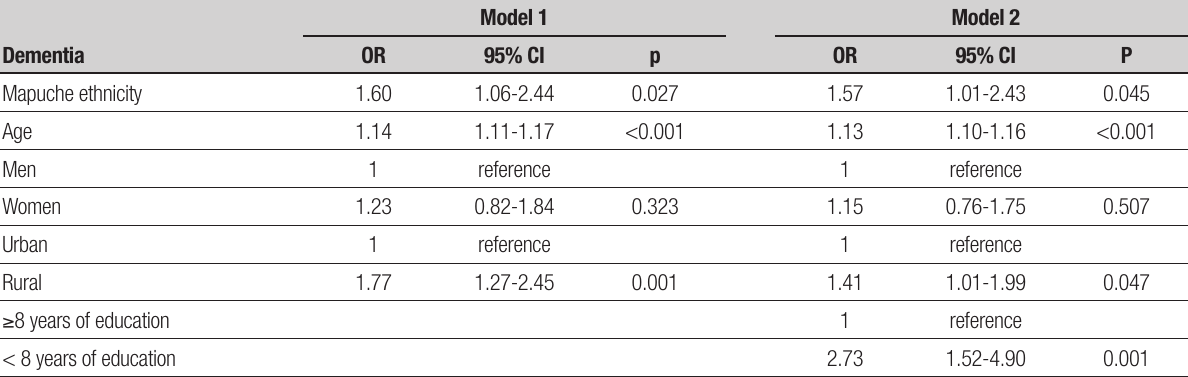
Table 5. Logistic regression model for association of dementia with Mapuche ethnicity adjusted by years of education, age, gender and rurality. Model 1 Model Dementia